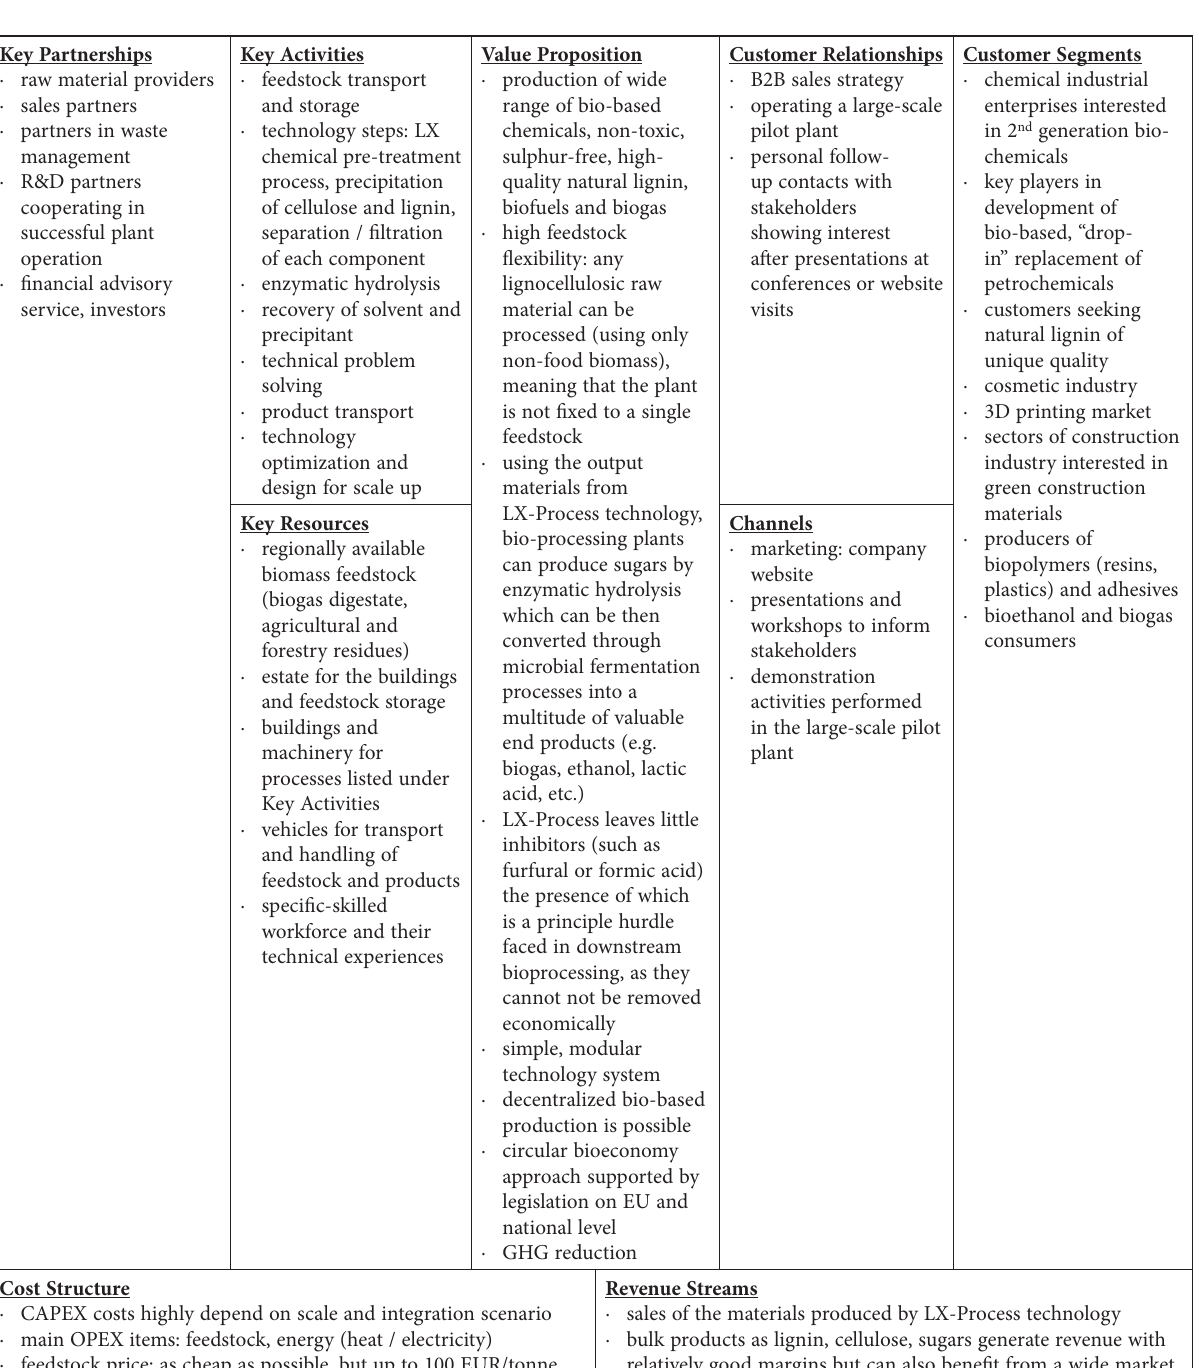
Figure 7. BMC of solution ‘S5’ (LXP Group,